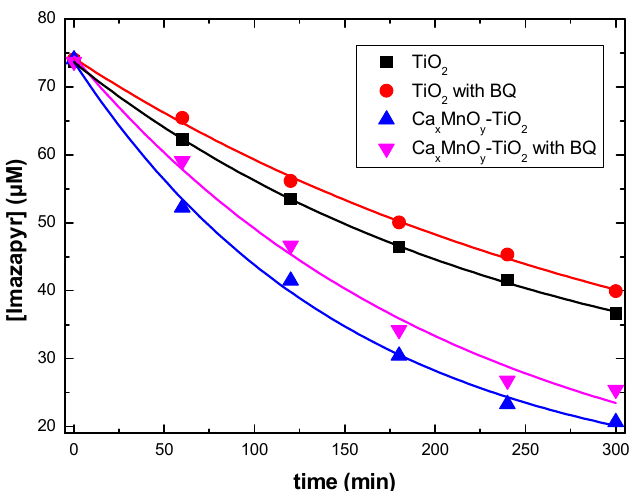
Figure 12. Imazapyr degradation in the presence of both catalyst in the presence and absence of BQ.